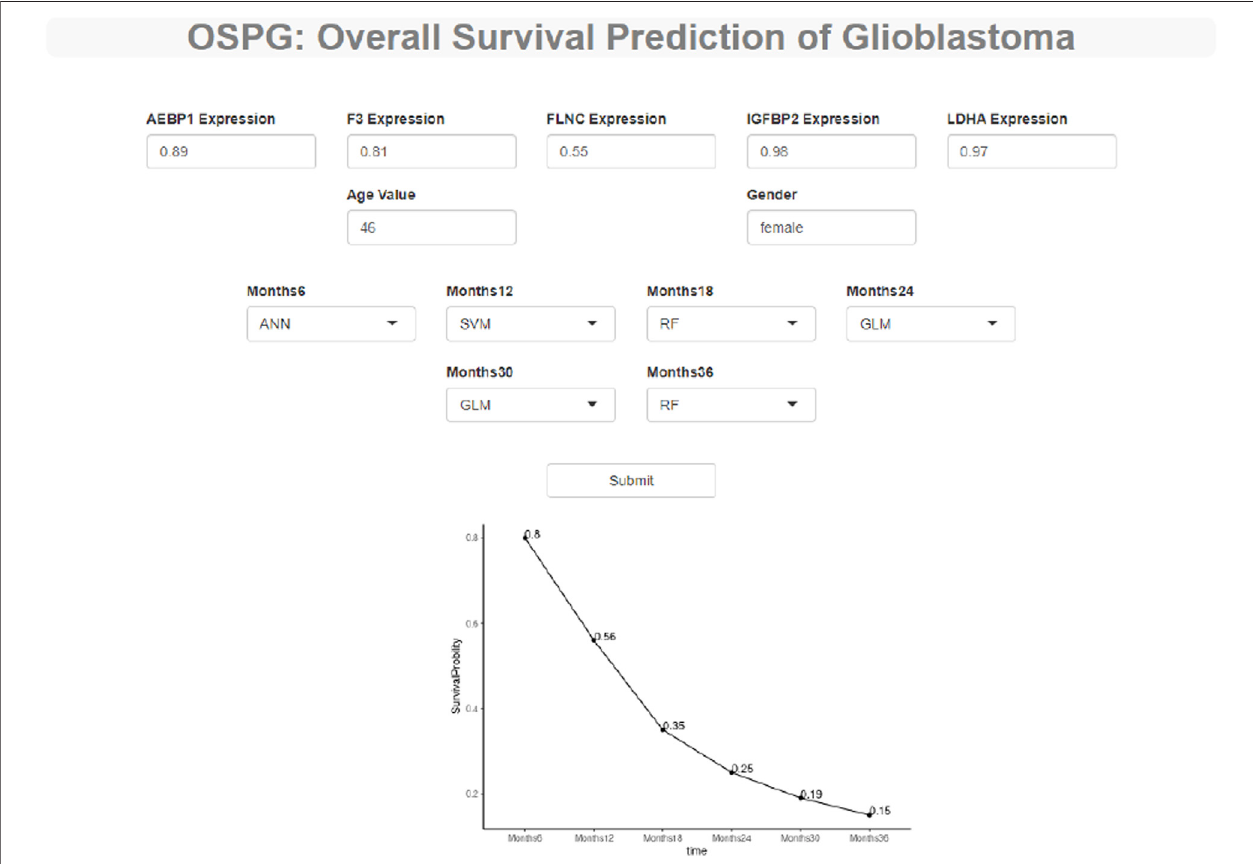
FIGURE 7 | OSPG: a web tool to explore and predict the overall survival status of the glioblastoma patients. OSPG can be used in four steps: (1) via the website https://ospg.shinyapps.io/OSPG/, (2) inputting the values of fi ve genes including AEBP1, F3, FLNC, IGFBP2, and LDHA (gene expression values range 0 to 1), (3) inputtingthe values ofage and gender (male or female) including AEBP1,F3, FLNC, IGFBP2, and LDHA (gene expression values range 0 to1), (4) selecting themachine learning models for each time point (6, 12, 18, 24, 30, 36 months), and (5) clicking the “ submit ” button.